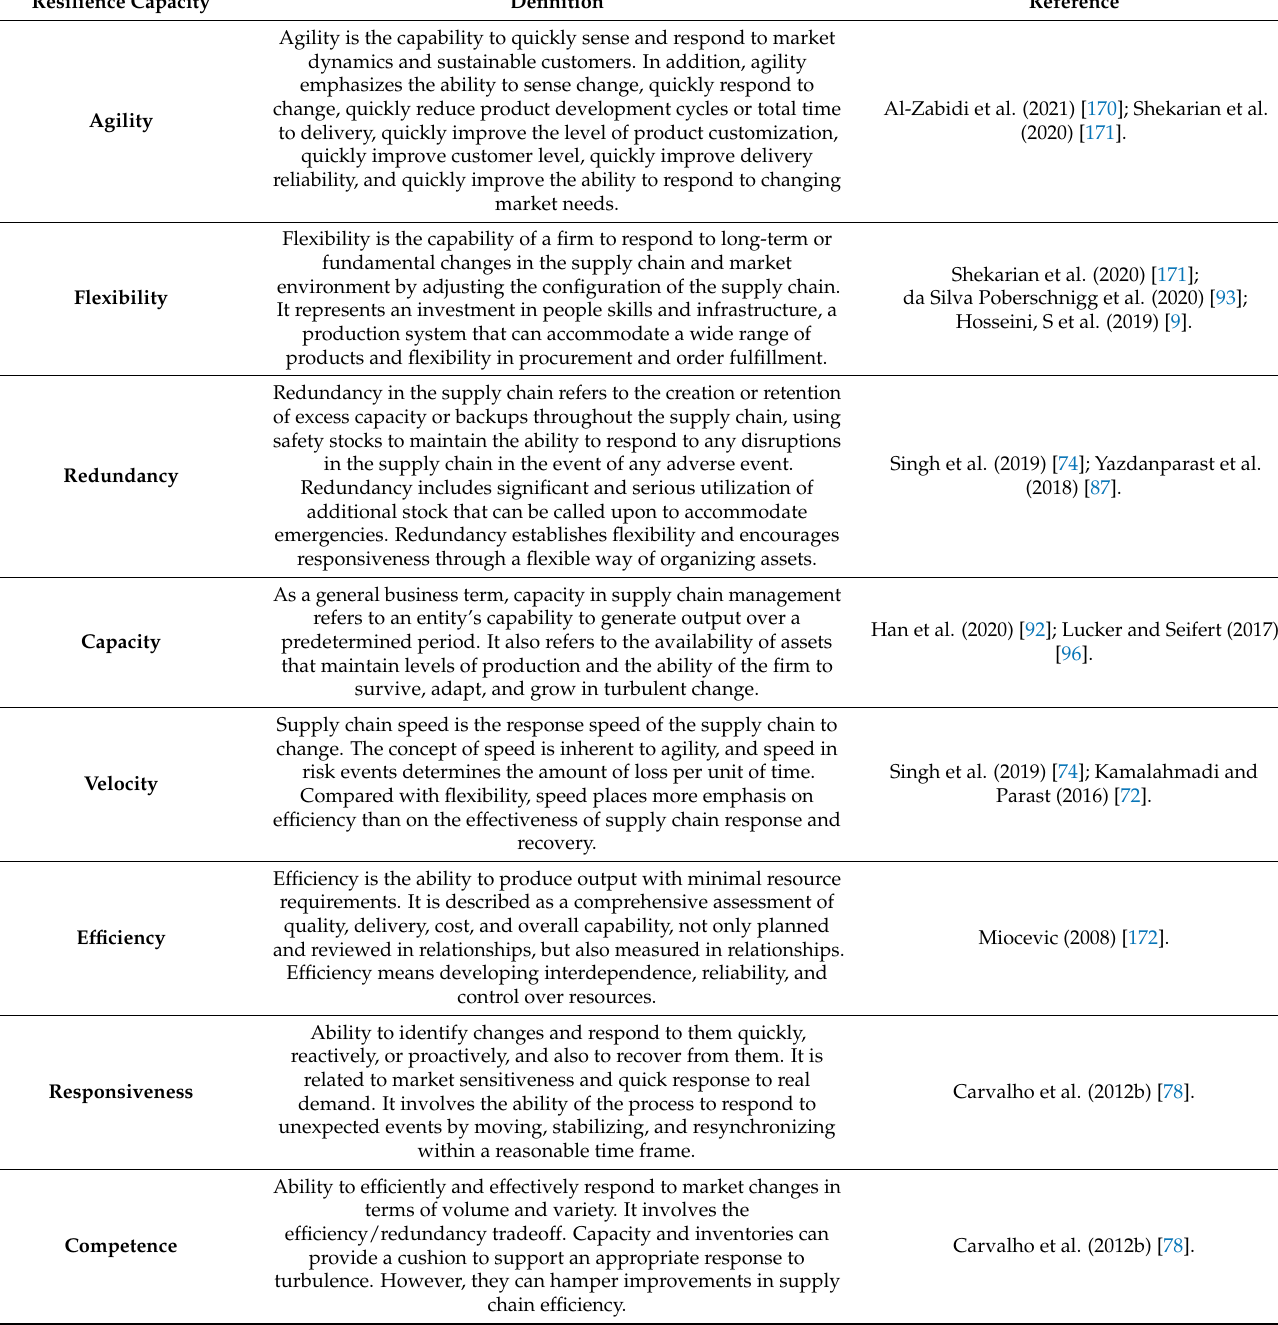
Table A3. The definitions for the chosen resilience